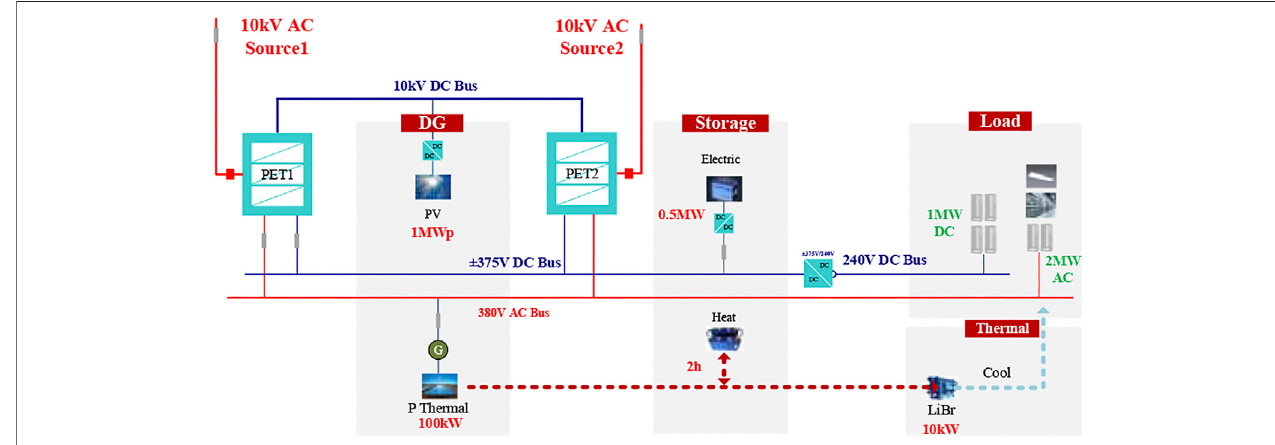
FIGURE 2 | AC/DC hybrid power system with multi-port PET cluster